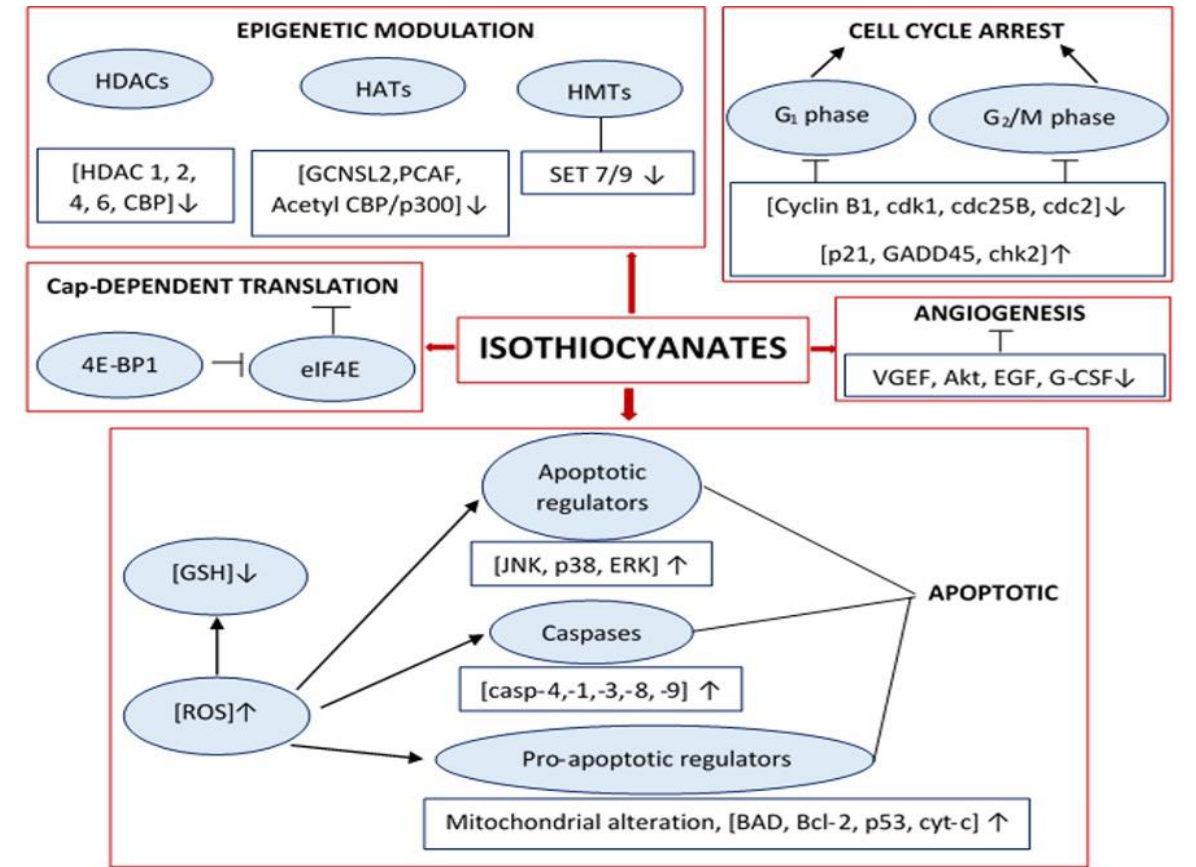
Figure 3. The involvement of ITCs in various cell signalling cascades associated with cell cycle arrest, epigenetic modulation, generation of oxidative stress, angiogenesis, and apoptosis. Arrowheads pointing upwards or downwards indicate an upregulation or downregulation of the expression of various indicated protein markers and ROS, respectively.